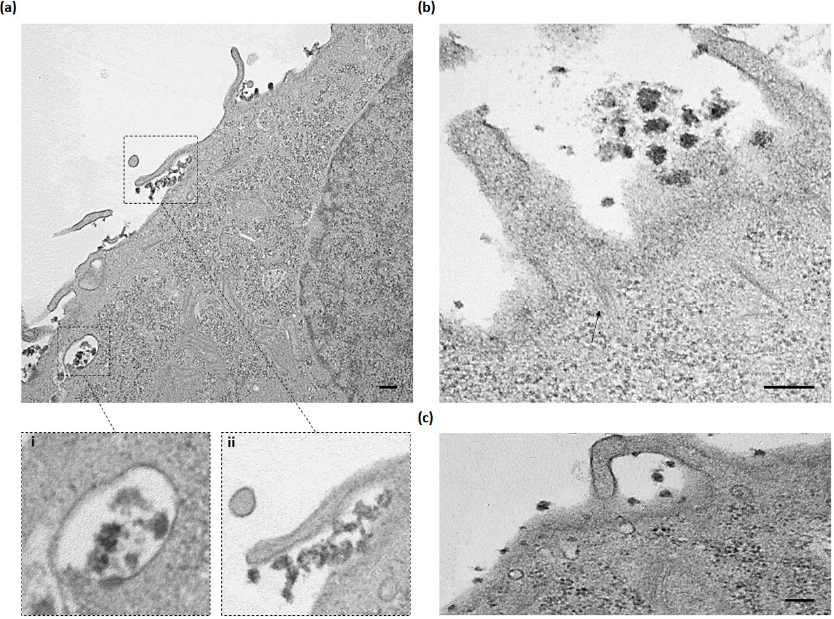
Figure 4. AuNC-PpIX-DOX complexes are internalized through a macropinocytic mechanism. ( a – c ) TEM micrographs showing AuNC-PpIX-DOX internalized into HeLa cells mediated by actin filaments (arrow). Scale bar: 0.2 μm.